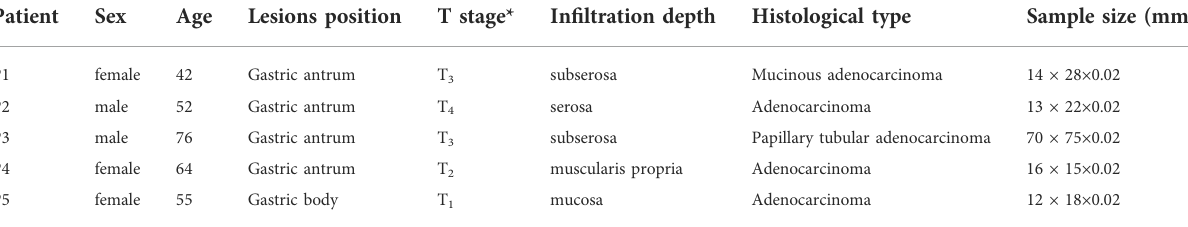
TABLE 1 Basic information of patients